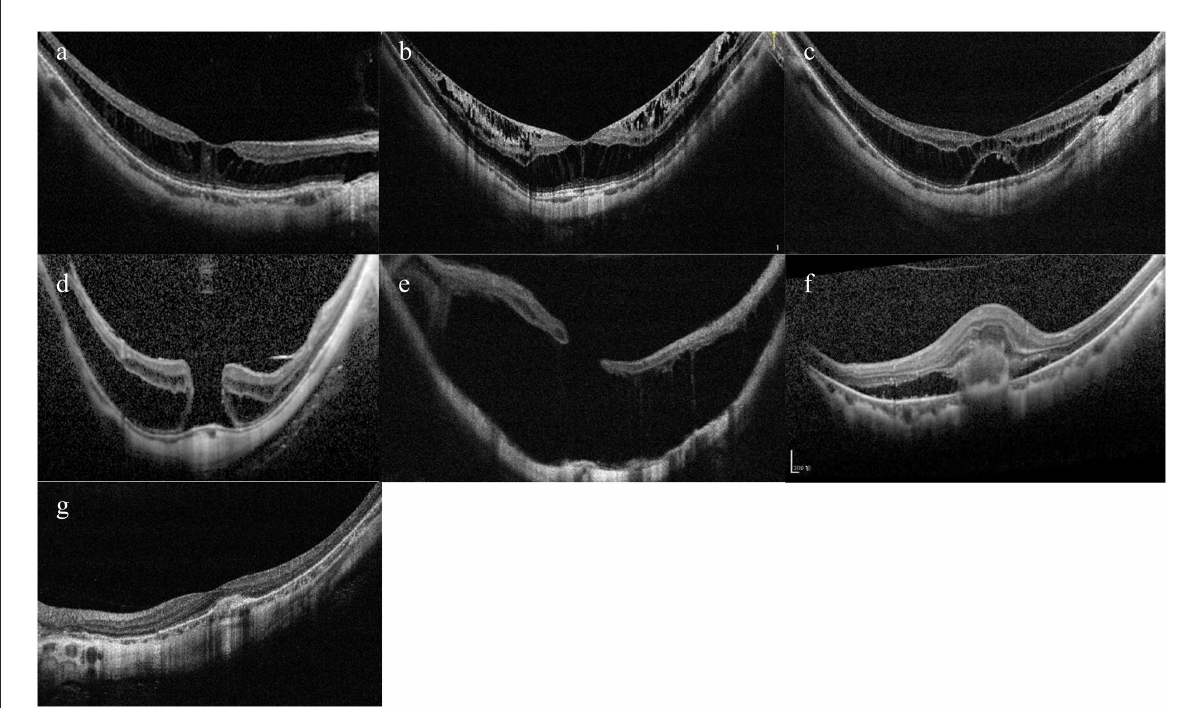
FIGURE1 Typical OCT images of tractional component and neovascular component. (A) Inner or outer foveoschisis (T1). (B) Inner + outer foveoschisis (T2). (C) Foveal detachment (T3). (D) Full-thickness Macular hole (MH) (T4). (E) MH + Retinal detachment (T5). (F) Active CNV (N2a). (G) Scar/Fuch’s spot